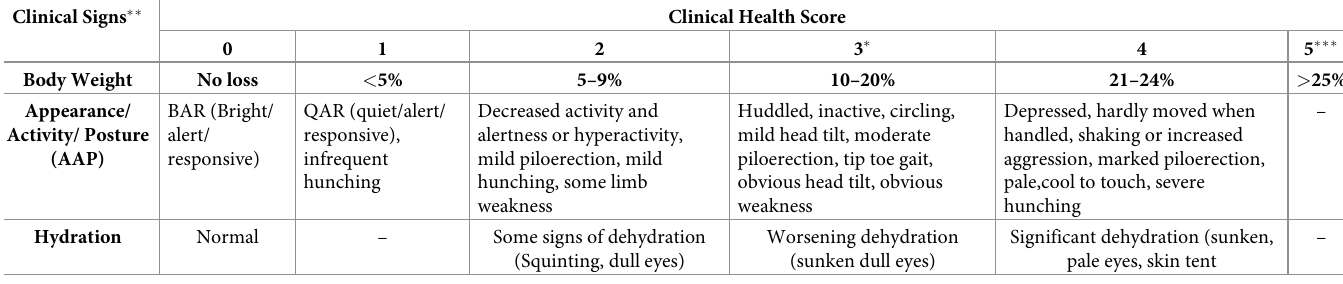
Blood glucose and ketone measurement At the end of each experiment, before euthanizing mice, one drop of blood was collected from the tail vein of mice and directly applied to a GE200 glucose measurement test strip that was read by the GE200 glucose monitor (GE, Auto Control Medical). Blood glucose was measured before administering anesthesia to prevent spikes in blood glucose due to stress and isoflurane treatment [58]. For measuring blood concentration of the ketone body β -hydroxybutyrate ( β HB), 0.5–1 ml of blood were collected with cardiac puncture after deeply anesthetizing mice with isoflurane followed by immediate cervical dislocation. Blood was added to tubes contain- ing K2-EDTA (BD Microtainer 365974), centrifuged at 1000 rcf for 12 min at 4˚C. Serum was then transferred into an Eppendorf tube and kept at -20˚C until further use. β HB concentra- Table 1. Clinical health score used to assess mouse health